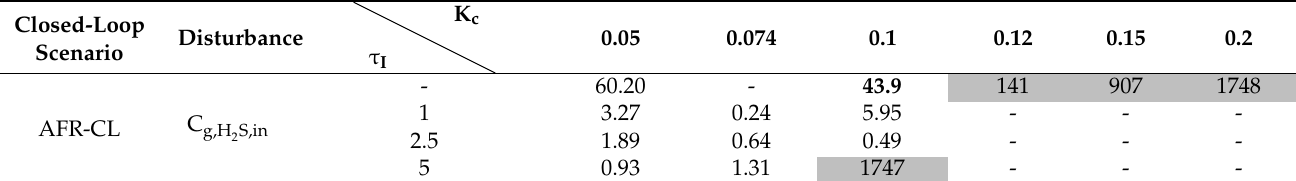
Table 5. Integral of the absolute value of the error (IAE) criteria results for the air flow regulation closed-loop (AFR-CL). In AFR-CL, an O 2 outlet concentration SP of 5.7% ( v / v ) was established to calculate the error. Values in bold represent the selected parameters while values shaded in gray provided an oscillatory response of the final control element.